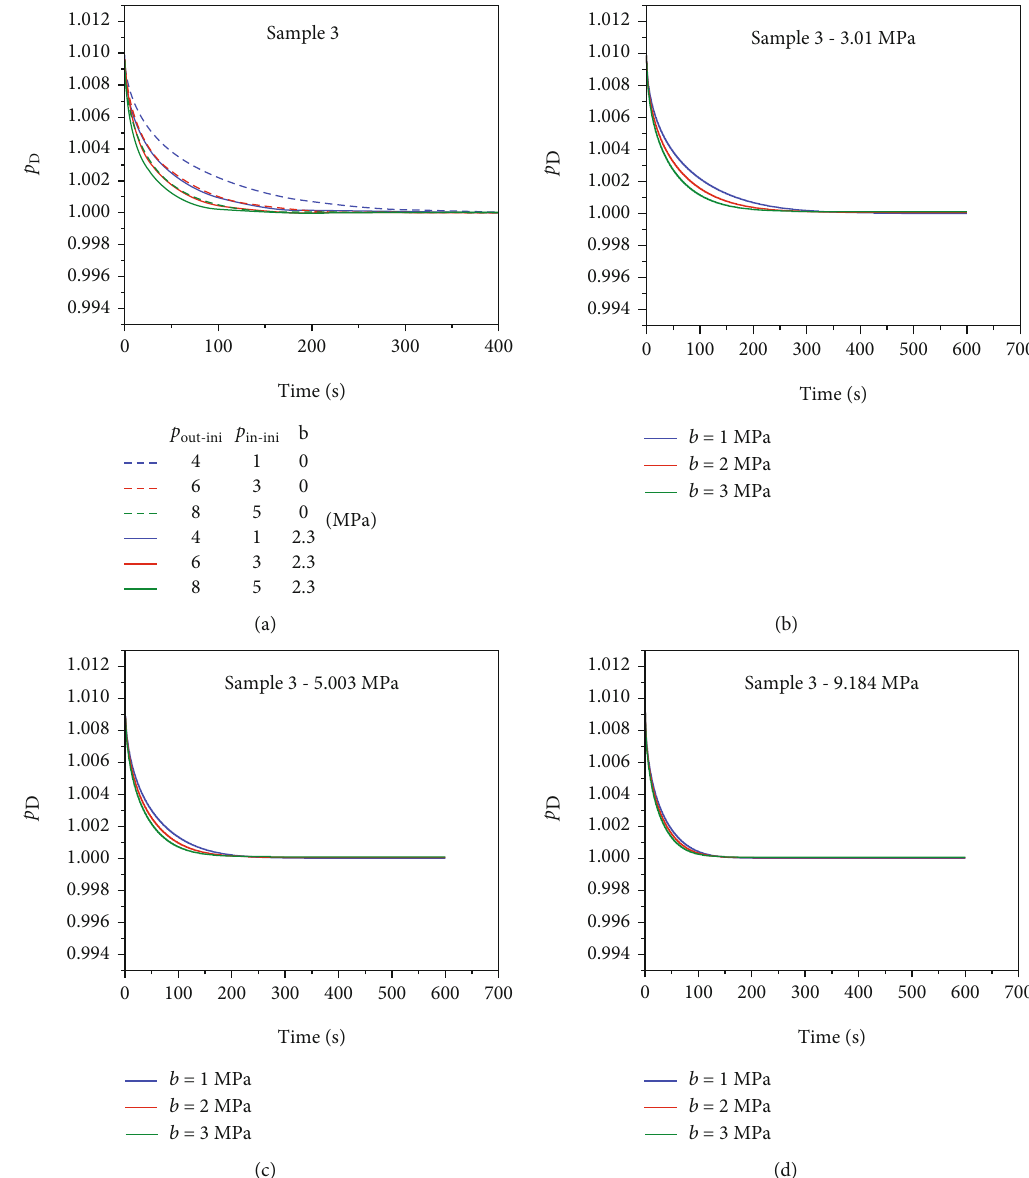
and p and in ‐ ini out ‐ ini = 0 and di ff erent p , i.e., (b) 3.01MPa, (c) 5.003MPa, and (d) in ‐ ini out ‐ ini